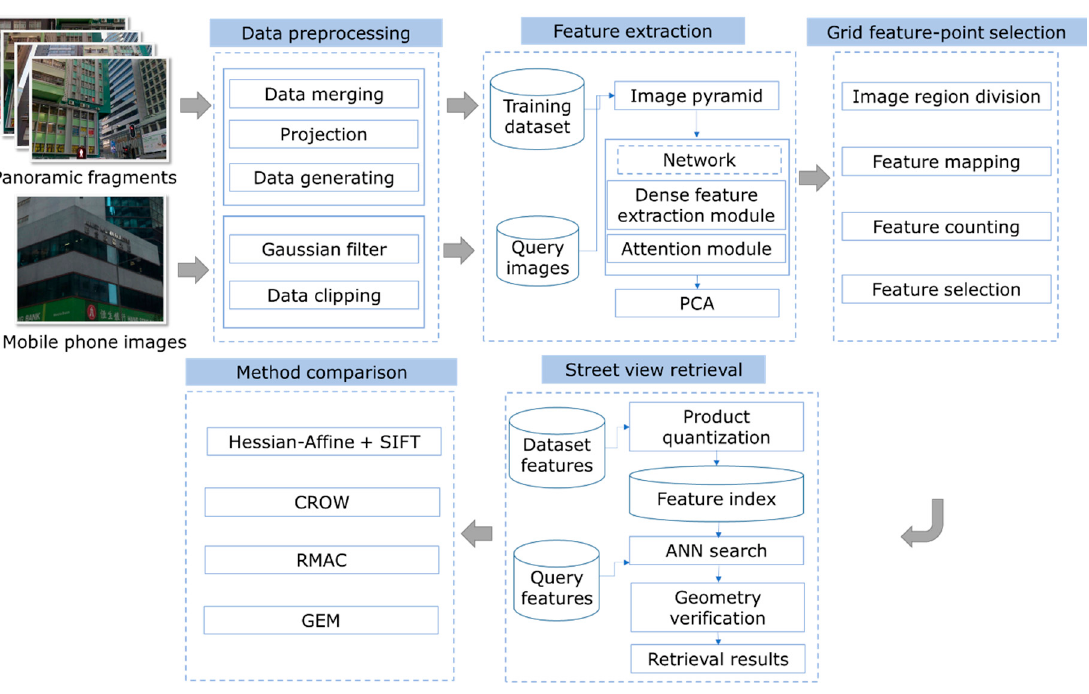
Figure 1. The street view image retrieval workflow.